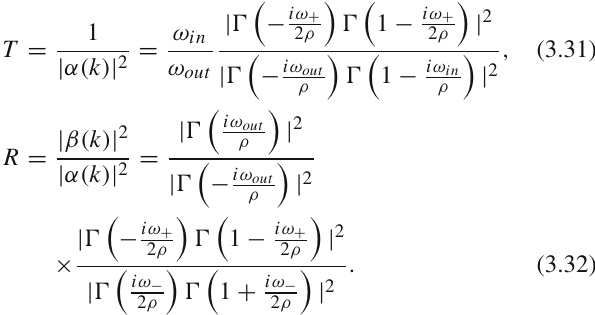
Fig. 6 Wave number dependence of the Bogoliubov coefficients from the mass profile I is shown here. Here we fix ρ =